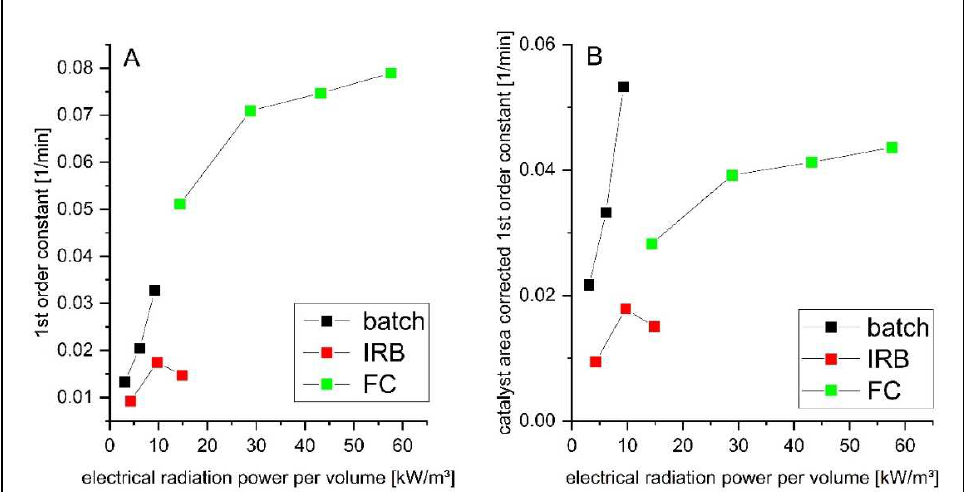
Figure 7. Mean 1st order reaction constant for the degradation of micro-pollutants with the batch, flat cell (FC), and immersion rotary body reactor (IRB) for varying electrical irradiation powers ( A ); mean 1st order reaction constant with a linear correction to a surface area to volume ratio of 50 m²/m³ ( B ) (all mean values without carbamazepine).